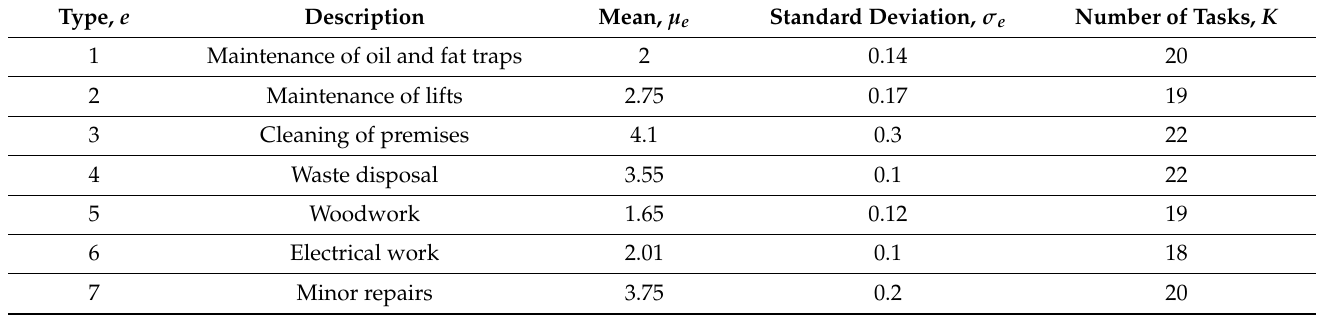
Table 4. Services offered and normal distribution parameters for testing durations.